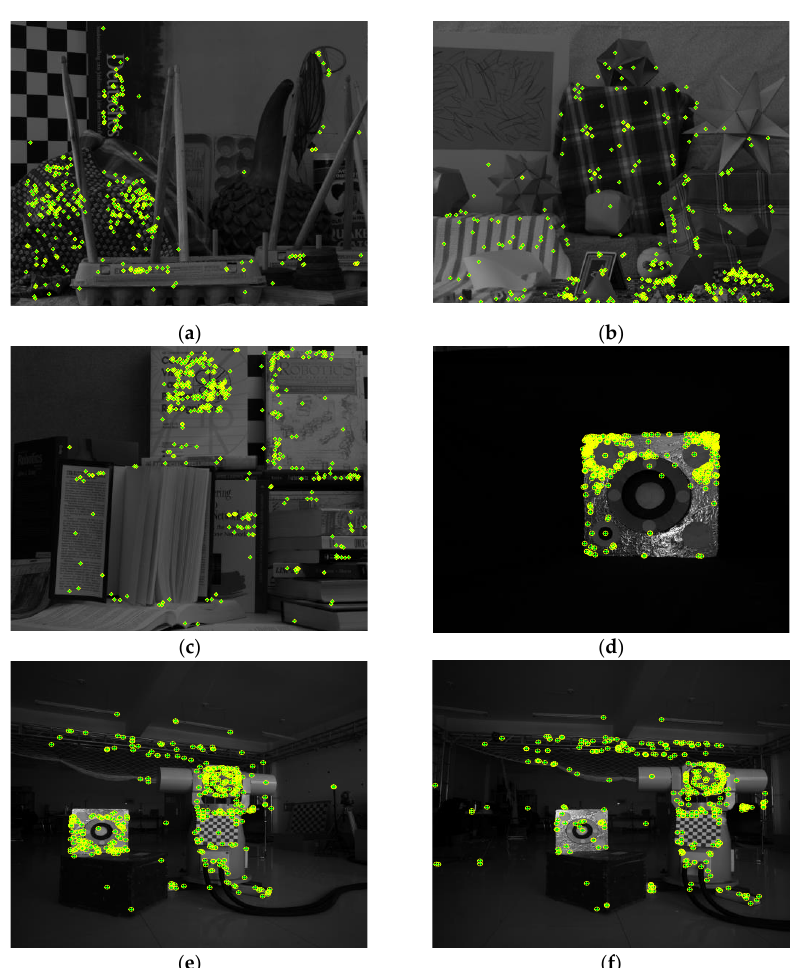
Figure 8. The feature points and intersection points in the intermediate images. ( a ) Feature points and intersection points in Image1; ( b ) Feature points and intersection points in Image2; ( c ) Feature points and intersection points in Image3; ( d ) Feature points and intersection points in Image4; ( e ) Feature points and intersection points in Image5; ( f ) Feature points and intersection points in Image6.